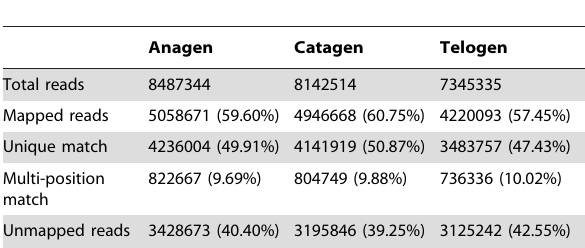
To confirm the differential expression of genes revealed by different development stages were chosen randomly for qPCR validation. The primers designed for qPCR analysis were listed in Table 1 and b -actin was used as a reference control.